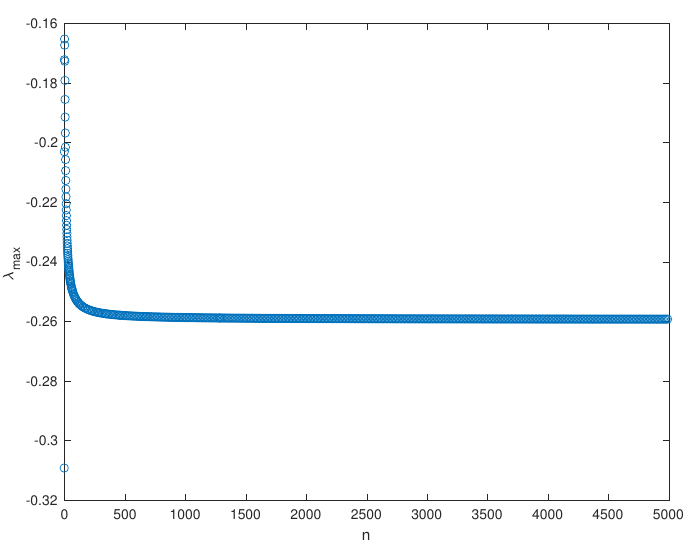
Figure 5. ω 0 = 1; µ 1 = 3; m 21 = 0.7; µ 3 = 5; α 1 = 0.2; α 3 = 1.5; α 5 = 2; k = 1; f = 1; σ =